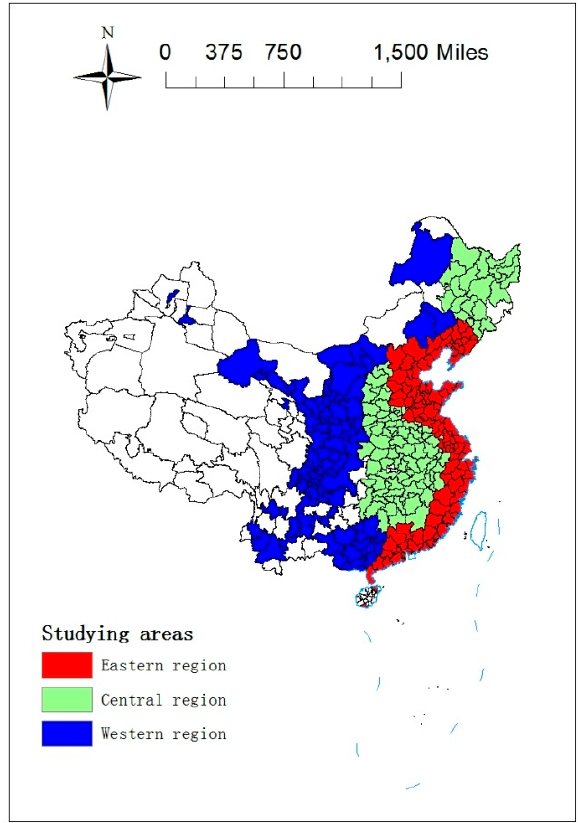
Figure 1. Studying Figure 1. Studying areas.